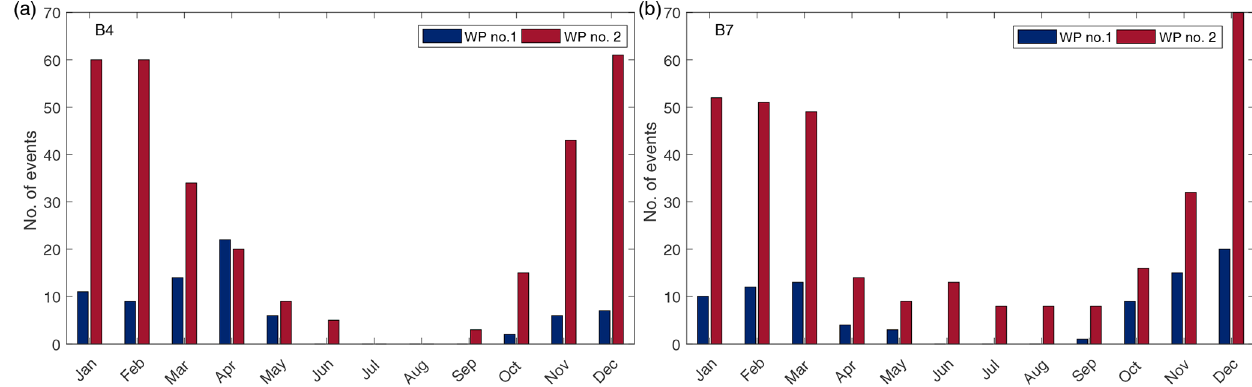
Figure 10. Monthly number of events for different WPs. (a) B4; (b)